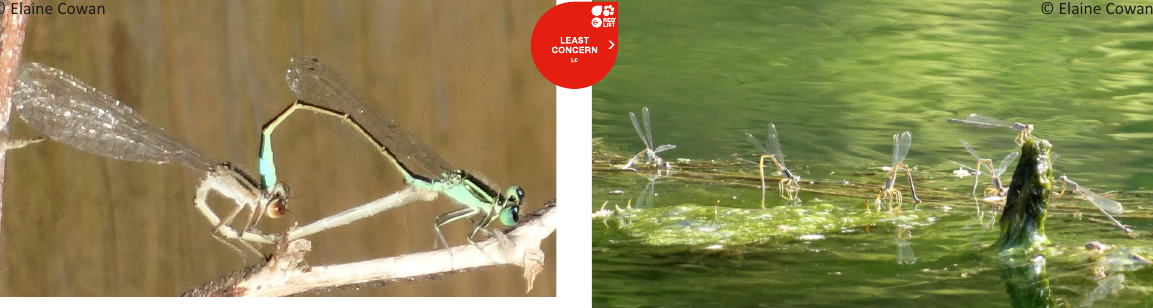
Image 3. Ischnura evansi mating wheel, 12 March 2014. Female brownish with small humeral black stripes and abdomen lighter ventrally. Image rotated 90 0 right.